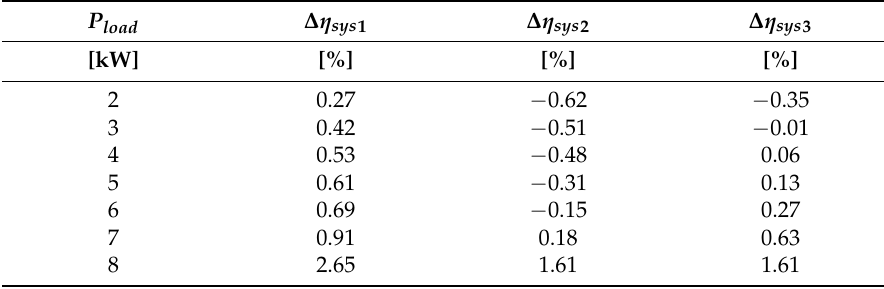
Table 2. The gaps in FC electric efficiency.